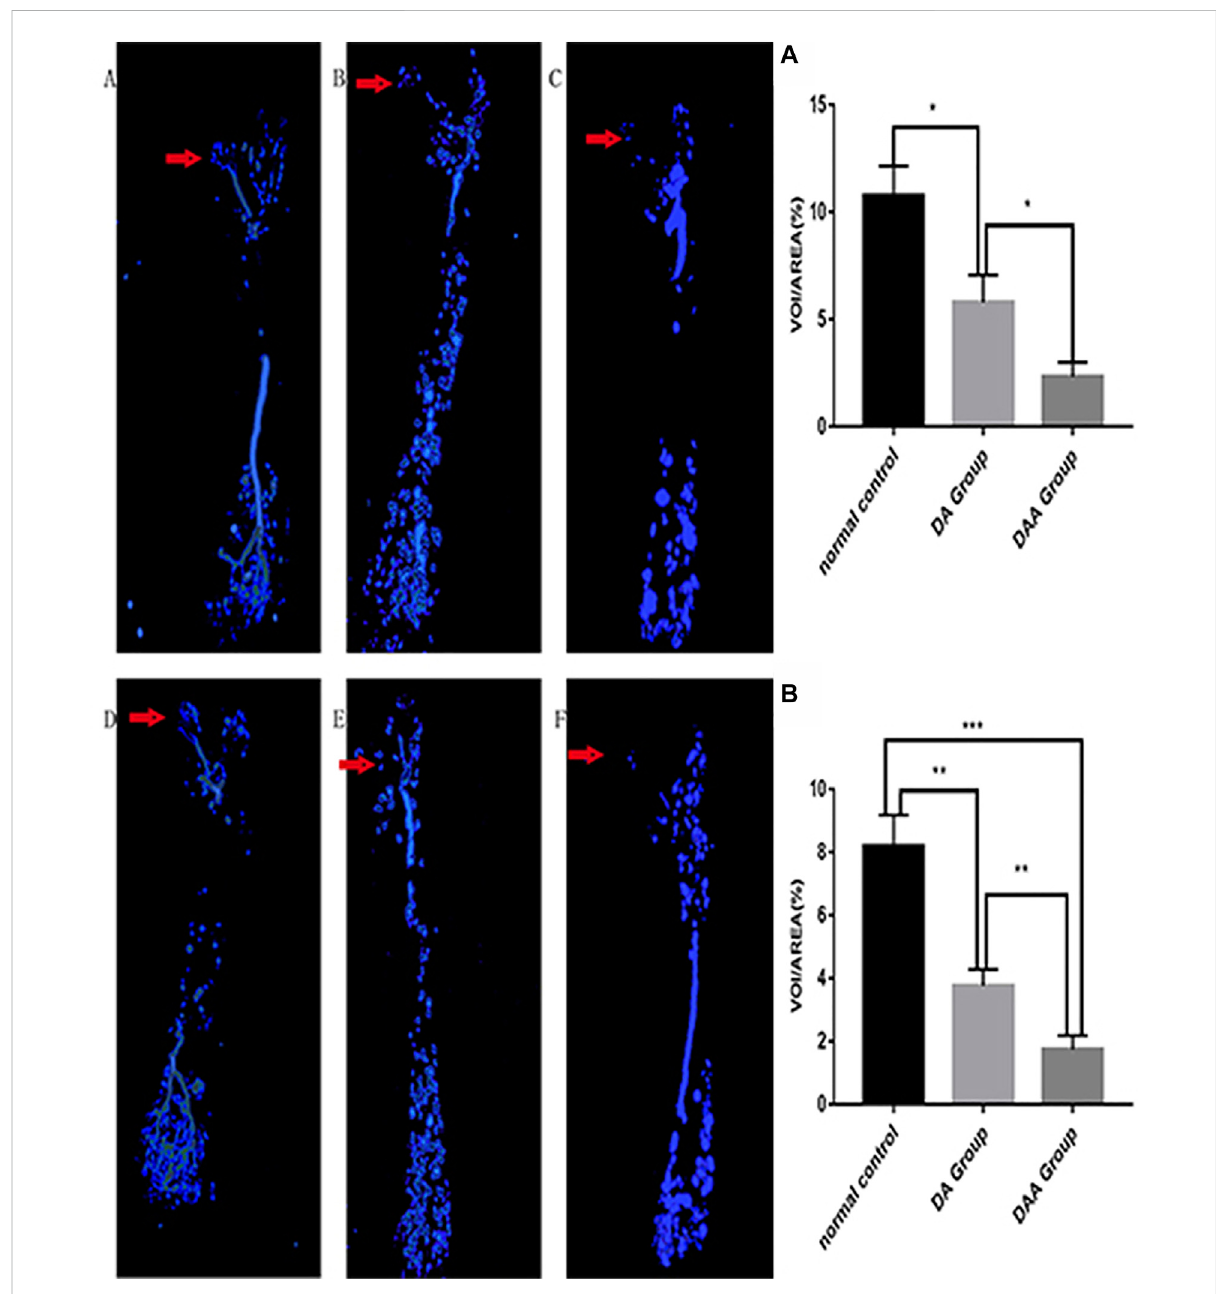
FIGURE 3 Analysis of blood vessels in the femoral head in the 4th (A – C) and 8th (D – F) weeks in the DAA group (C,F) , DA group (B,E) , and normal control group (A,D) . The red arrow indicates the area of the femoral head. Representative 3-D microangiographic images of blood vessels in the femoral heads of the mice in each group; the blue area represents the blood vessels in the femoral heads. Quanti fi cation of the total blood vessel volume in the femoral head [the number of femoral head vessels in three mice was statistically analyzed in the 4th (A) and 8th (B) weeks]. The data are presented as the mean ± standard deviation, * p <